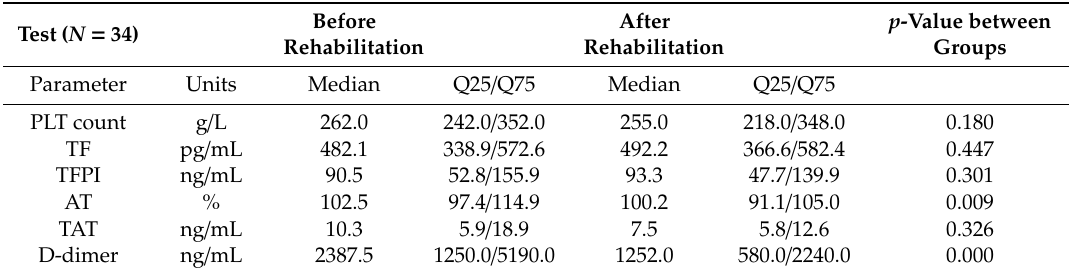
Table 4. Parameters of hemostasis before and after a four-week rehabilitation program in patients from group I (three weeks to three months after injury).